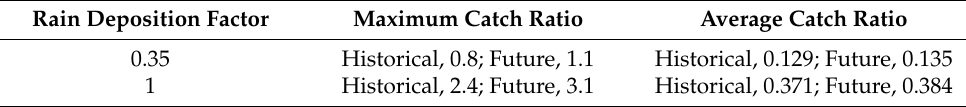
( a ) Catch Ratio vs. Wind Speed, F D = 0.5, Historical ( b ) Catch Ratio vs. Wind Speed, F D = 0.5, Future Averaged Catch Ratio = 0.186 Averaged Catch Ratio = 0.192 Figure 4. Scatter plot of catch ratio against wind speed using a rain exposure factor of 1. Table 4. Catch ratio for F D = 0.35 and F D =